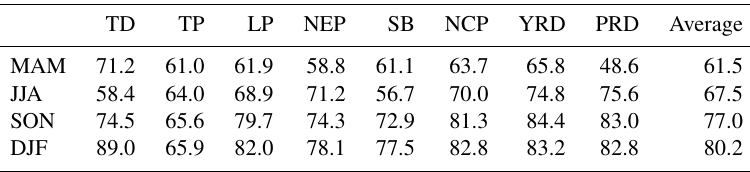
Table 2. Ratio of the AOD within 1.5km height above the ground to the total column AOD (%). TD TP LP NEP